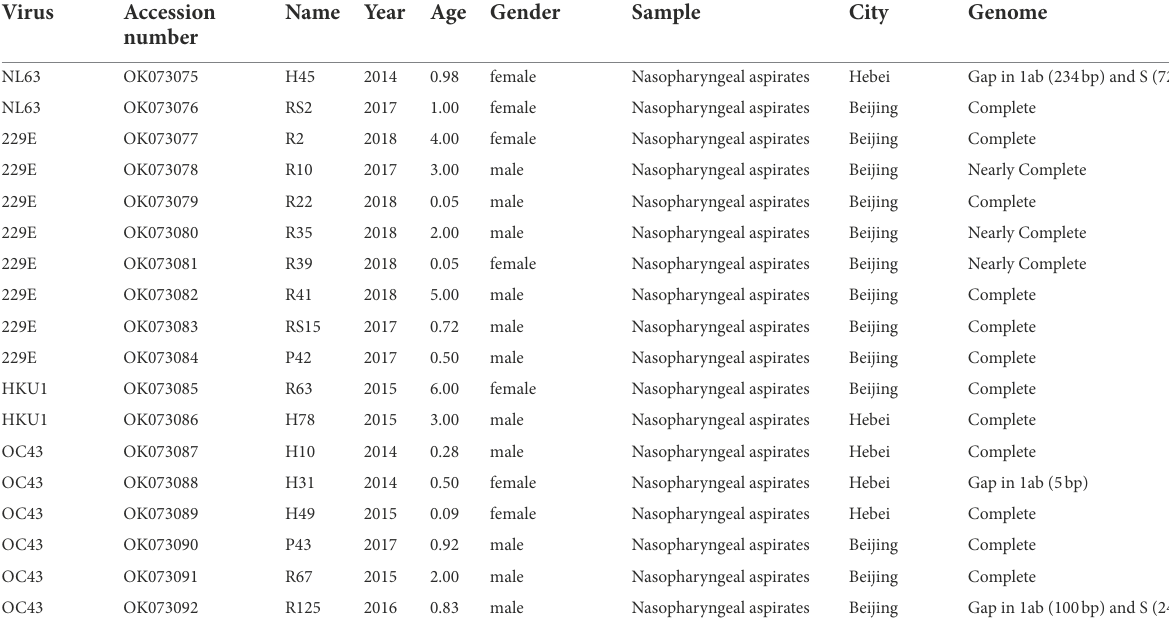
TABLE 1 Information of four human coronaviruses identified in this study.